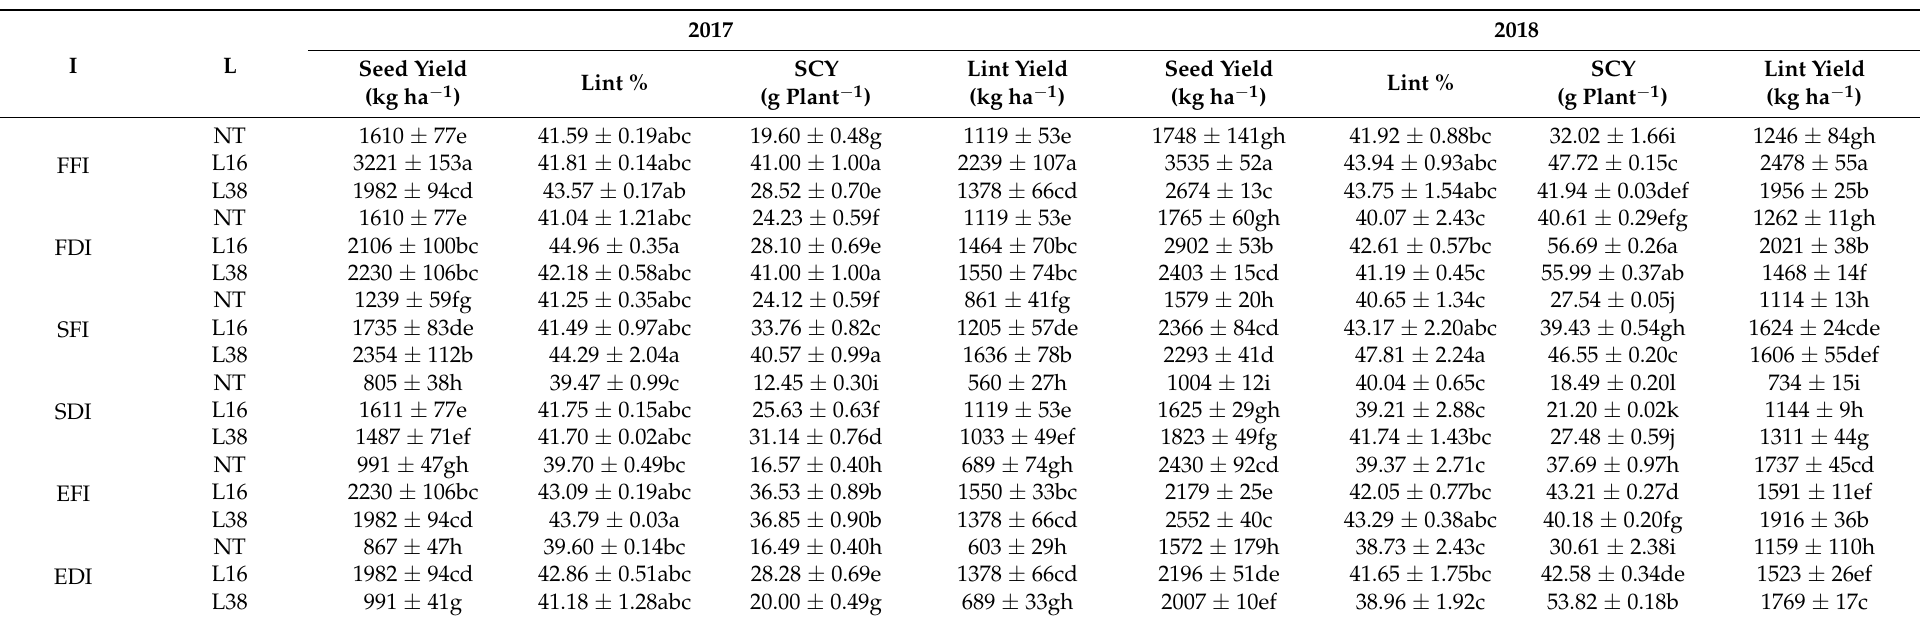
Table 1. Cotton yield components from plants exposed to different irrigation treatments in 2017 and 2018